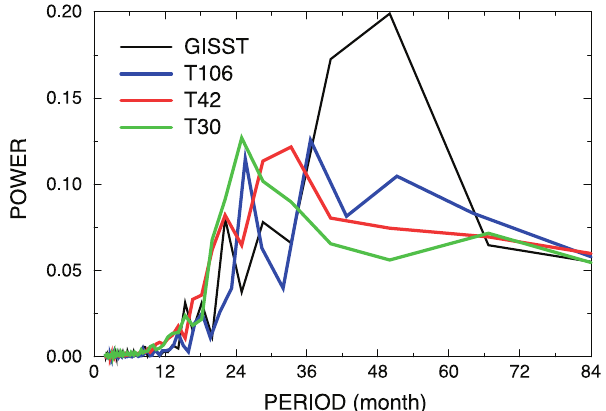
Fig. 14. NIÑO-3 SSTA spectrum. Black curve as obtained from the GISST data set; blue curve: T106 experiment; red curve: T42 experiment; green curve: T30 experiment. Before to compute the spectra the NIÑO-3 SSTA time series were normalized by their respective standard